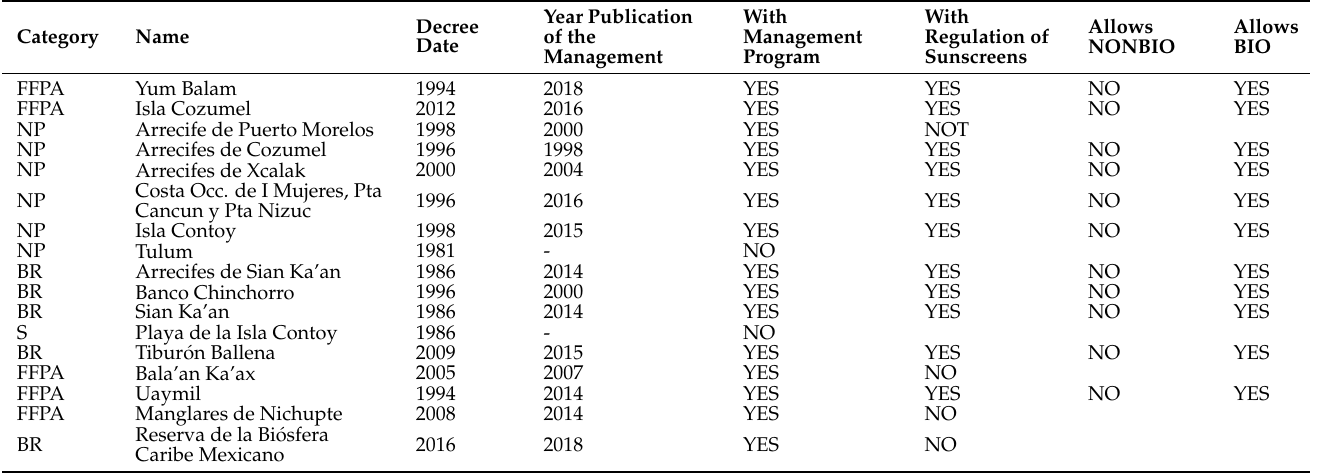
From our survey of visitors to the region, we found that 78% of people understood that conventional sunscreen can cause pollution, and 58% said biodegradable sunscreen can also be a pollutant. Despite this, the vast majority chose to use conventional sunscreens (not biodegradable), while 10% mentioned using biodegradable or ecological sunscreens. In the state of Quintana Roo, the use of sunscreen in sinkholes is only regulated in two of the eleven municipalities (Solidaridad and Tulum, Table 1), which still allow the use of biodegradable sunscreens. Table 1. Analysis of the regulation of the use of sunscreen in protected aquatic systems of the Yucatan Peninsula. FFPA: Flora and Fauna Protection Area; BR: Biosphere Reserve; NP: National Park; S: Sanctuary; BIO, biodegradable sunscreen; NONBIO, non-biodegradable sunscreen.